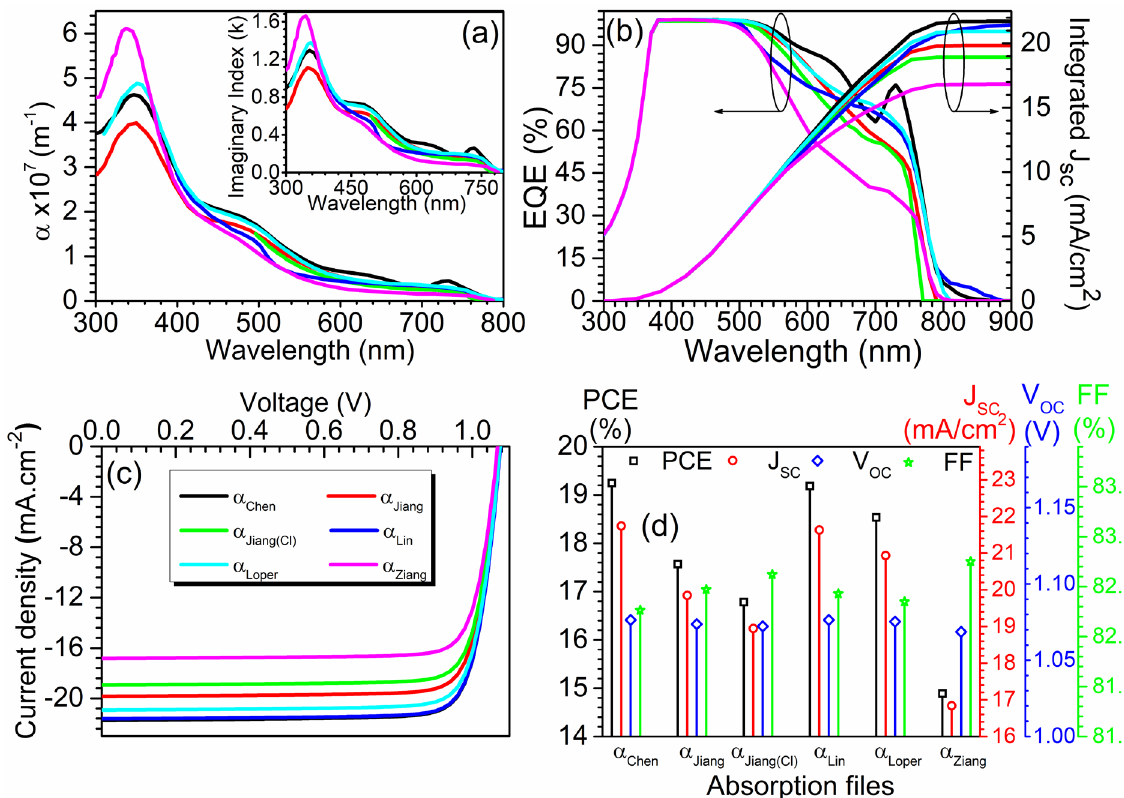
Figure 3. ( a ) Calculated room temperature absorption coefficient data for CH 3 NH 3 PbI 3 and CH 3 NH 3 PbI 3 (Cl). Inset shows published room temperature k values (Data sources are Chen et al. 38 , Jiang et al. 39 , Lin et al. 40 ,